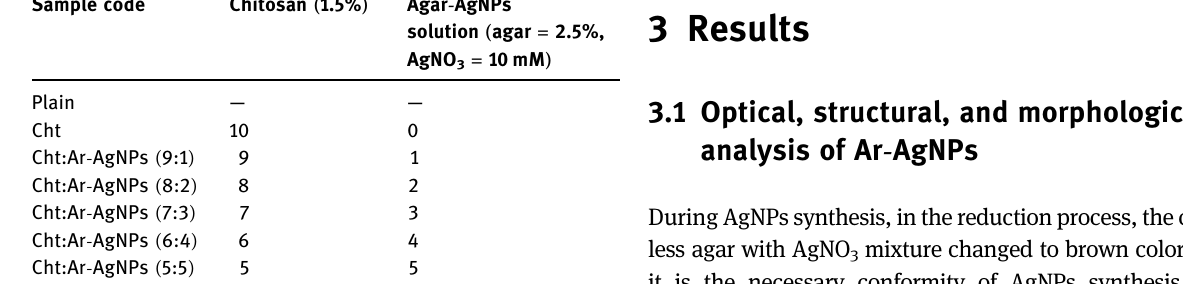
Table 1: Di ff erent ratios of chitosan and agar - AgNPs - coated cellulose paper and their respective coating weight ( g ) Sample